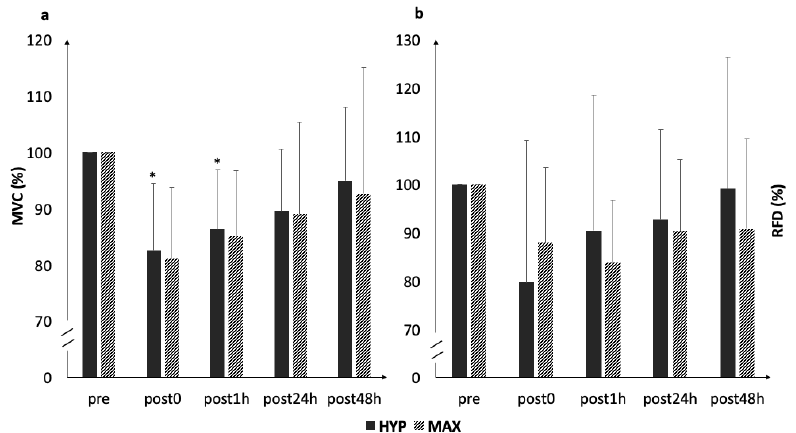
Figure 3. Acute changes in ( a ) maximum isometric force and ( b ) rate of force development. * statistically significant difference to baseline ( p < 0.05).